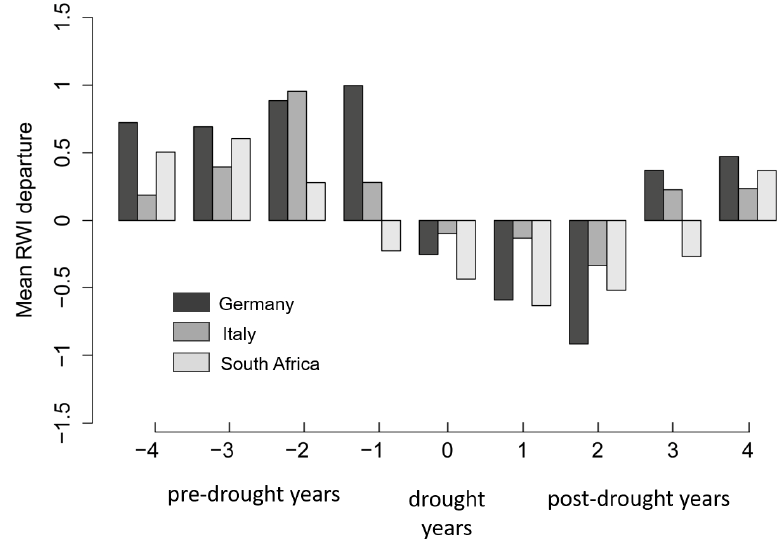
Figure 9. Mean ring-width indices (RWIs) departures for the averaged values for the drought years considered in the superposed epoch analysis (SEA). Dark grey columns represent the oaks from Germany, light grey columns those from Italy, and white columns those from South Africa. Years on the X -axis show: the years before ( − 4 to − 1), the drought years (0), and the years after the drought (1 to 4).